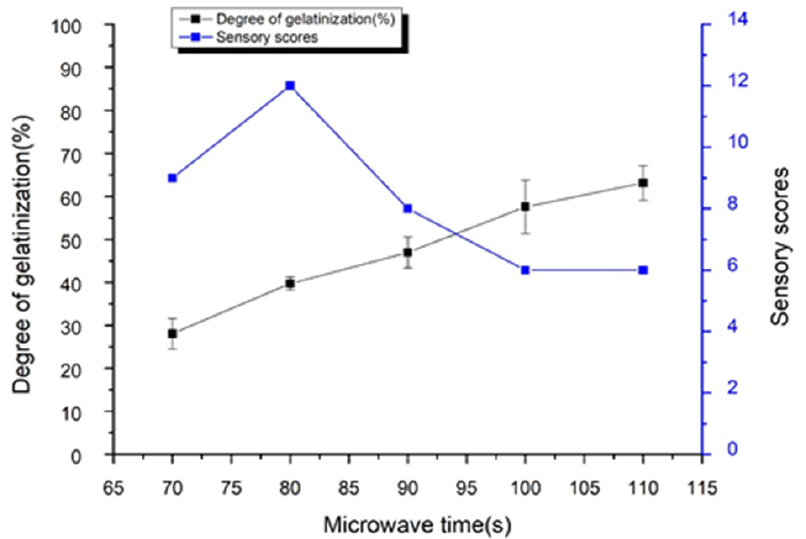
Figure 3. Changes in degree of gelatinization and sensory scores of adzuki beans pre-cooked of different microwave time.